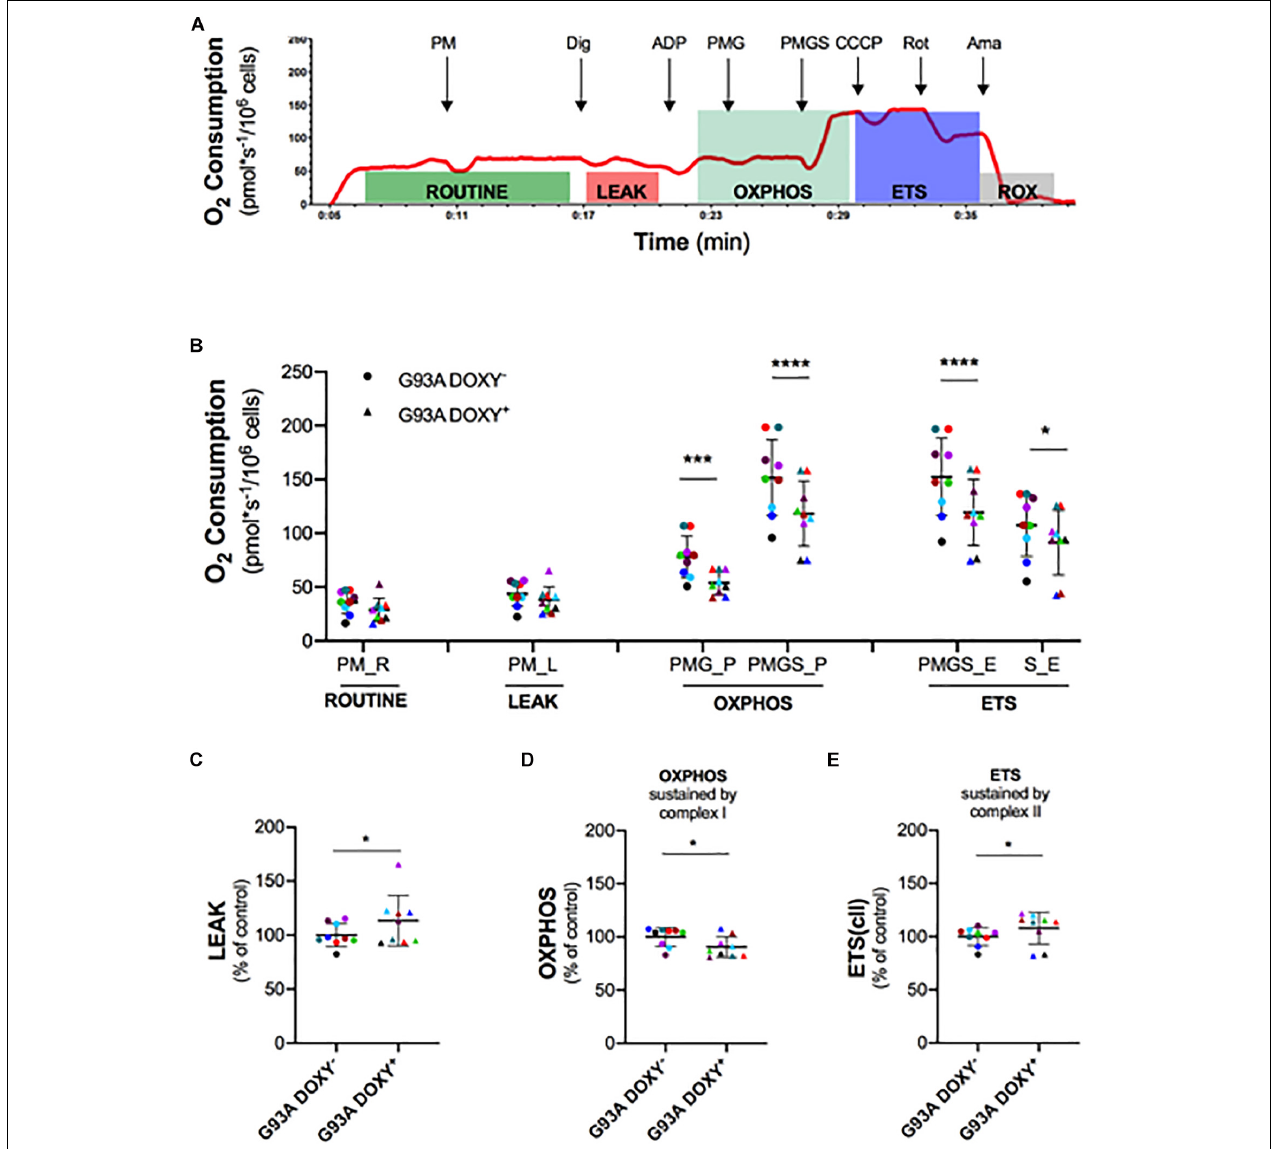
FIGURE 3 | Mitochondrial complexes contribution to oxidative phosphorylation in permeabilized G93ADOXY+ and G93ADOXY– cells. (A) Rate of oxygen consumption (red line) of permeabilized G93ADOXY– cells measured at 37 ◦ C in Mir05 in the following states: the ROUTINE respiration sustained by pyruvate and malate (PM) and endogenous substrates; the LEAK respiration evaluated following permeabilization with digitonin; the ADP addition stimulated OXHPOS capacity sustained by complex I (pyruvate, malate and glutamate, PMG) and complex II (pyruvate, malate, glutamate and succinate, PMGS); the maximal uncoupled ETS capacity (addition of CCCP); ETS sustained by complex II following inhibition of complex I by rotenone; the ROX, residual oxygen consumption, following addition of the inhibitor of complex III antimycin A. (B–E) Dot plots corresponding to respirometry experiments, showing data from all samples. Each dot corresponds to one sample. The line shows the mean with standard deviation. Paired samples are represented by symbols of the same color. (B) Quantitative analysis of the rate of oxygen consumption of G93ADOXY– and G93ADOXY+ permeabilized cells: the values relative to ROUTINE, LEAK, OXPHOS, and ETS for paired samples are reported. (C–E) Flux control ratios, normalized to the maximal uncoupled ETS capacity, of G93ADOXY–, and G93ADOXY+ permeabilized cells in the LEAK, OXPHOS and ETS(cII) respiratory states. Data are represented as percentage of control (G93ADOXY– cells). Data of flux control ratios (mean ± SD) in G93ADOXY– cells are: (C) LEAK (0.28 ± 0.03), (D) OXPHOS(PMG) (0.50 ± 0.04), and (E) ETS(cII) (0.69 ± 0.05). Analysis of G93ADOXY– vs. G93ADOXY+ cells at various respiratory states was performed using two-way ANOVA (Holm-sidak’s post hoc correction) ∗ p < 0.05, ∗∗∗ p < 0.001, ∗∗∗∗ p < 0.0001 (B) ; paired student T test (C–E) ∗ p < 0.05. n =